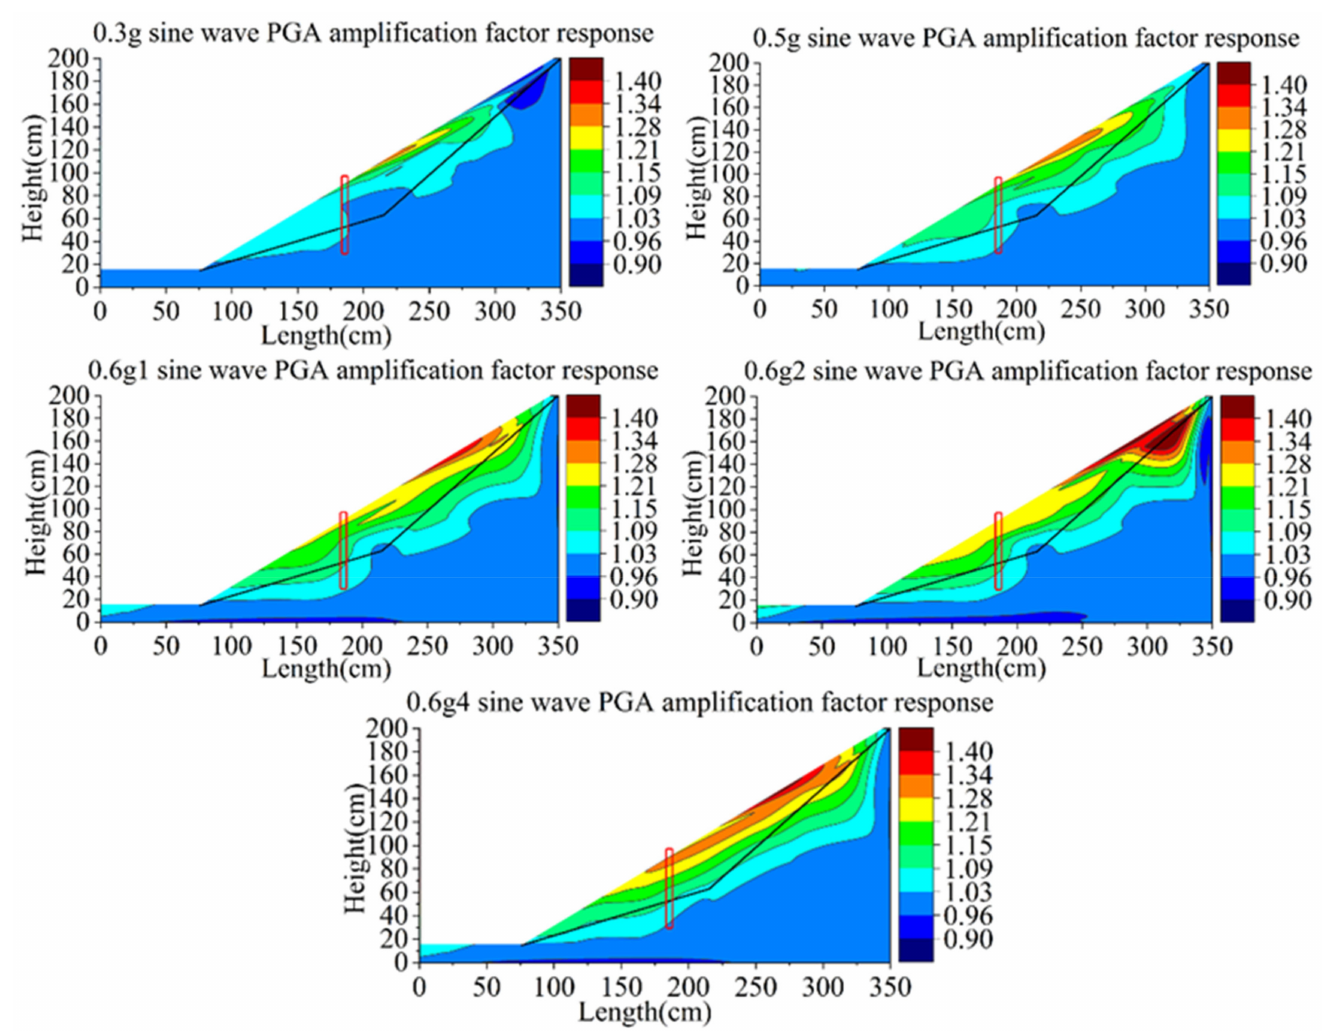
Figure 15. Contours of PGA amplification coefficient of model